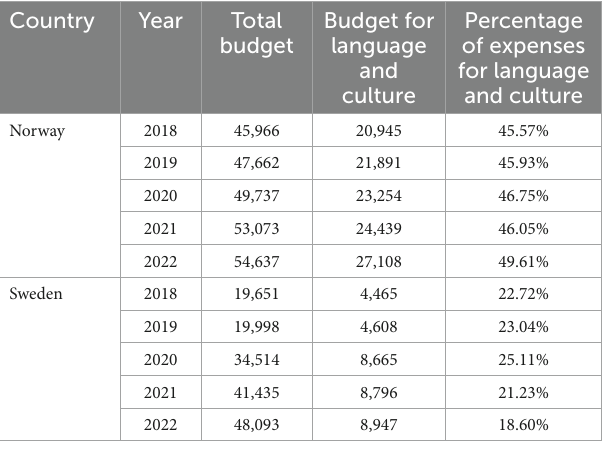
TABLE 2 Budget for Sami Parliament Budget in Norway and Sweden from 2018 to 2022 (EUR